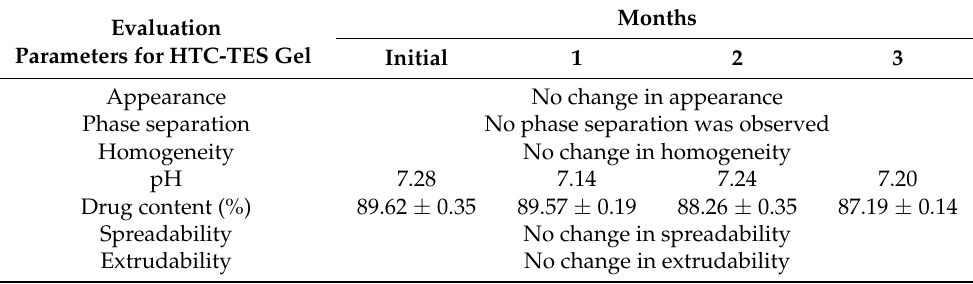
Table 6. Stability studies for optimized HTC-TES gel stored at 25 ± 2 ◦ C/60 ± 5%.